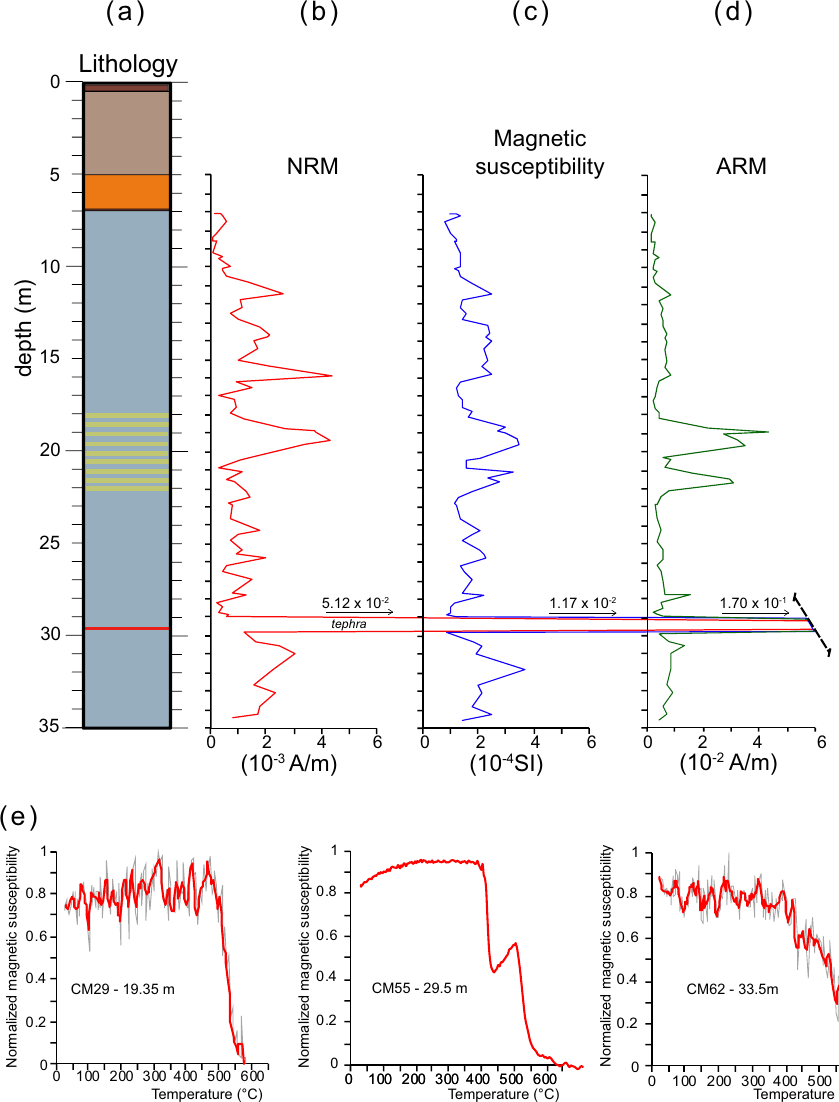
Figure 4. Mineral magnetic data for CM1. ( a ) lithology, ( b ) stratigraphic variations of NRM intensity, ( c ) κ and ( d ) ARM. ( e ) Temperature dependence of κ (up to 700 °C) for three representative samples: CM29 (19.35 m), CM55 (29.5 m), CM62 (33.5 m). For samples CM29 and CM62 a three-point moving average is applied (red